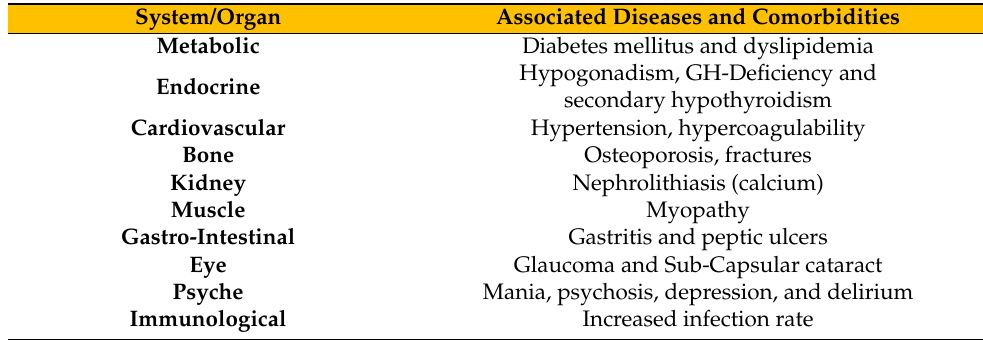
Table 1. Main diseases, comorbidities and alterations in Iatrogenic Cushing’s